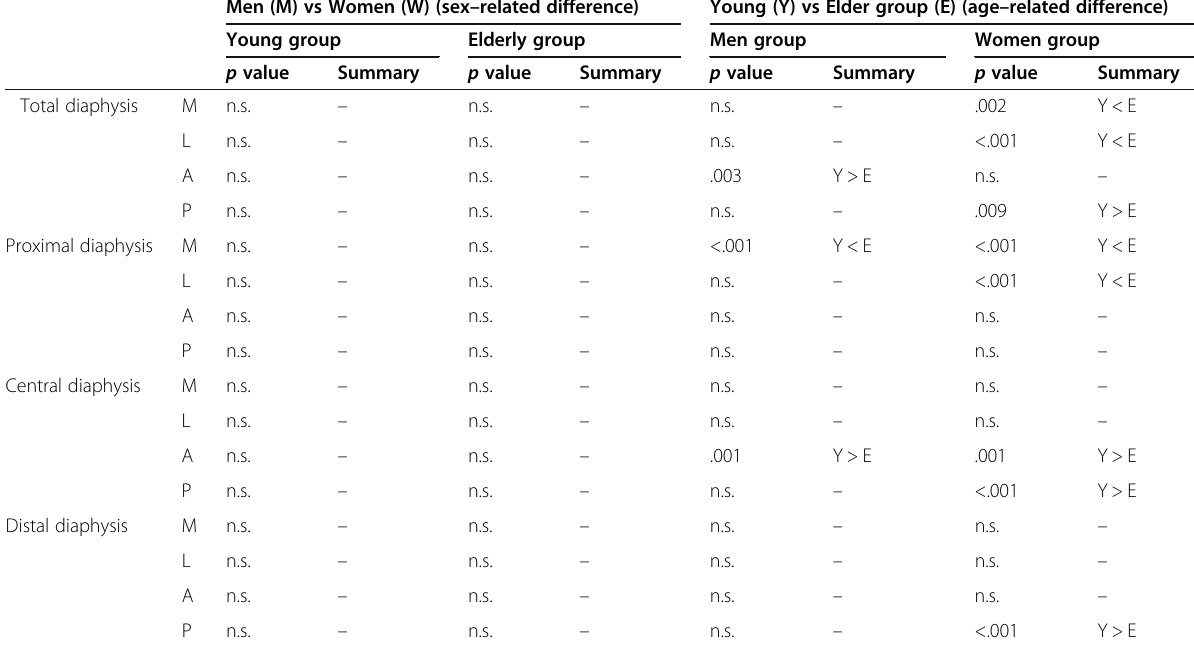
Table 4 Sex – and age – related differences Men (M) vs Women (W) (sex – related